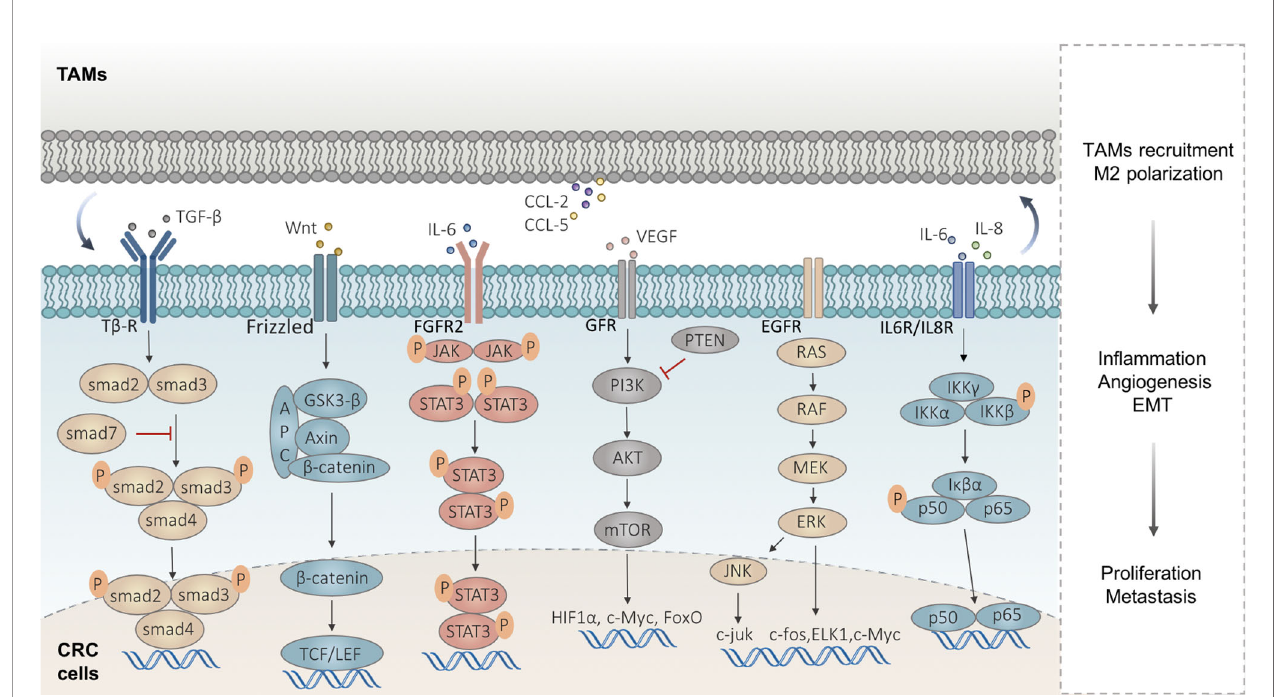
FIGURE 2 | Signaling pathways implicated in macrophages in CRC metastasis. Wnt/ b -catenin signaling is activated in highly proliferative CRC accompanied by the TAM in fi ltrates. TAMs upregulate the VEGF-A of CRC cells and activate the NF- k B signaling pathway by secreting IL-6 and IL-8. TAMs produce IL-6 to activate the JAK/STAT3 signaling in CRC cells and lead to the EMT, which in turn lead to the CCL2/5 secreted by CRC cells, to promote macrophage recruitment. Some exosomes carrying miRNAs derived from CRC cells regulate PTEN, by activating the PI3K/Akt signaling to induce M2-like TAM polarization, and in turn, TAMs promote CRC metastasis by enhancing EMT and secreting VEGF. The abnormal activation of the MAPK signaling pathway can induce tumor cell proliferation and participates in the development and metastasis of CRC. TAMs facilitate the EMT program involved in the CRC metastatic process via TGF- b /Smad